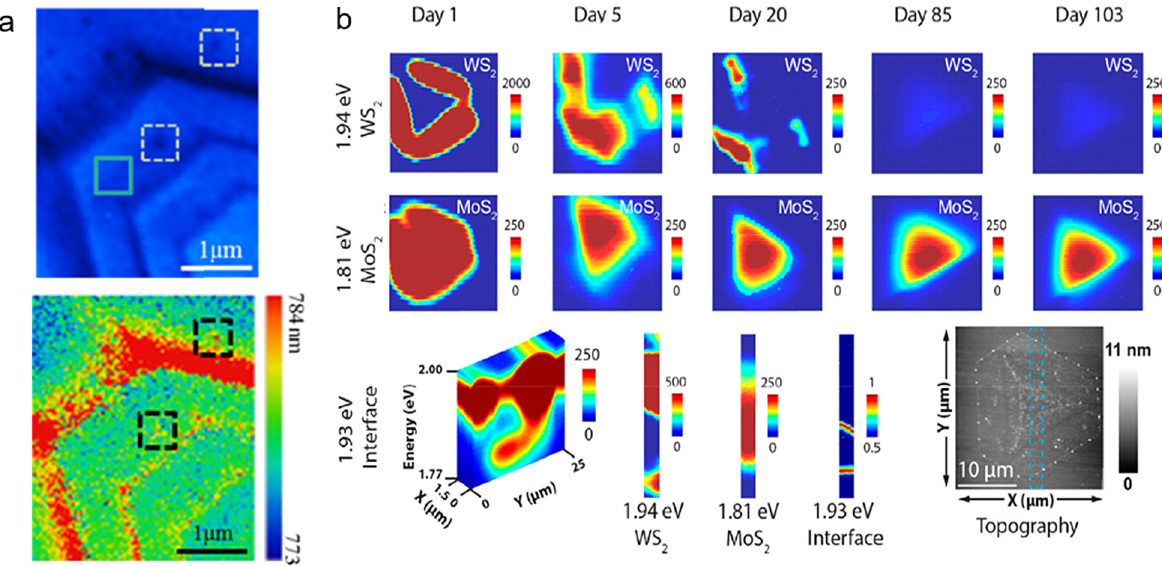
Figure 6: TEPL images that show the aging effect of TMD HJ (a) TEPL intensity (upper panel) and peak position (lower panel) images. Squares display the location of nanoparticles formed by aging effect. Reproduced with permission from ref. [97]. Copyright 2019, Optical Society of America. (b) TEPL images obtained at 1.94 eV (upper) and 1.81 eV (center) and interface (lower). Reproduced with permission from ref. [103]. Copyright 2021, American Chemical